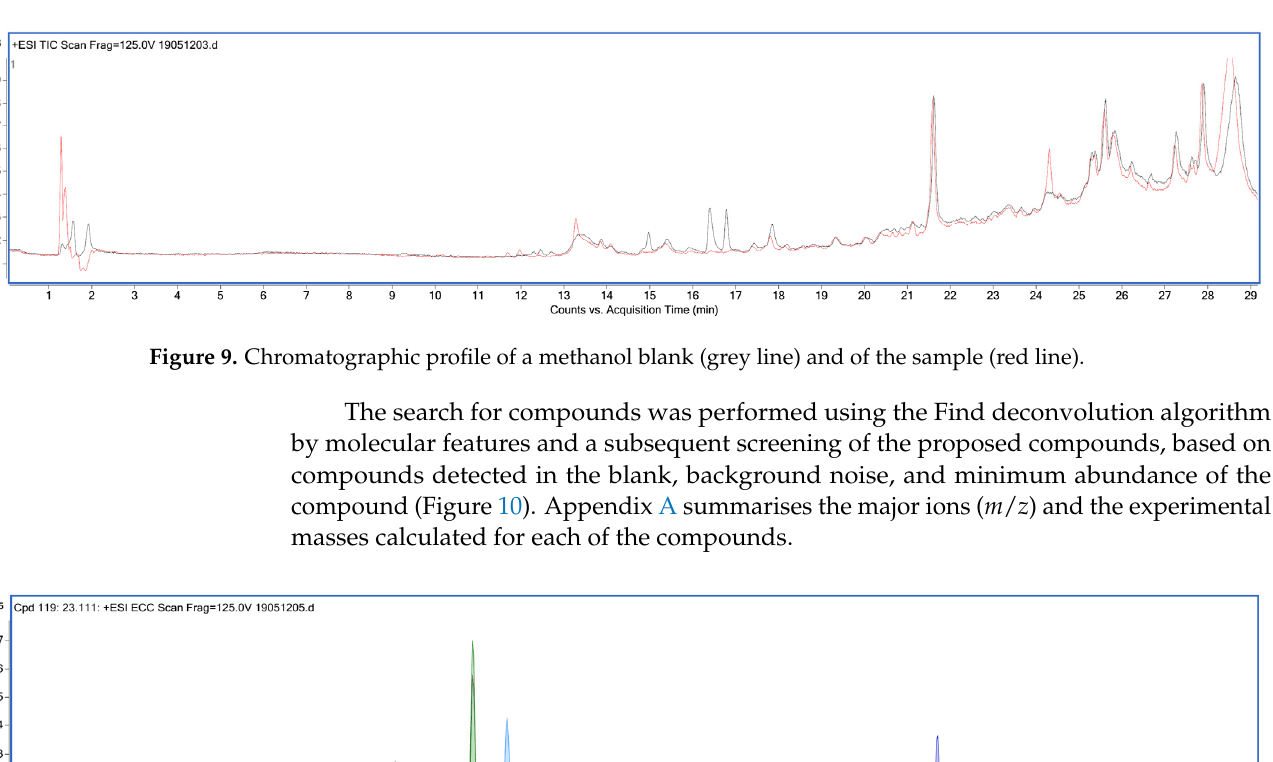
Figure 10. Chromatographic profile of the major compounds in the oxidised carbamazepine